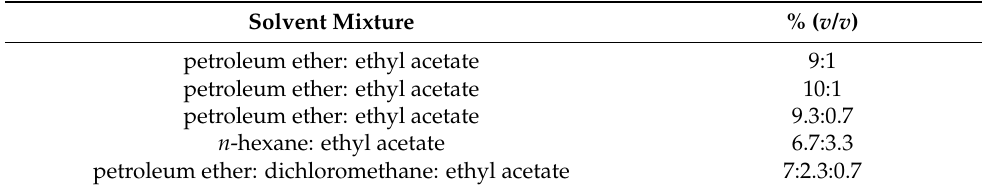
Table 1. Development of thin layer chromatography using different operating solvent systems. Solvent